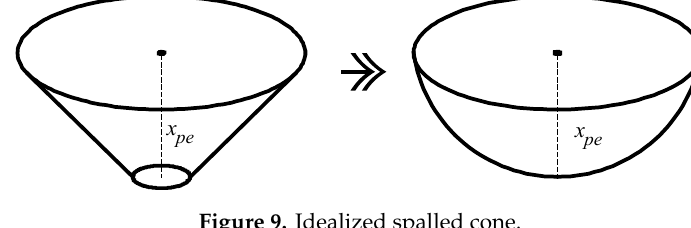
Figure 9. Idealized spalled cone.